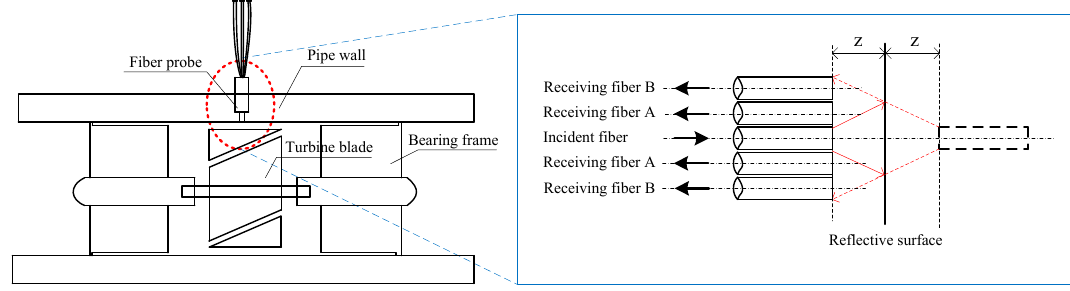
Figure 1. Fiber turbine flow sensor operating principle.